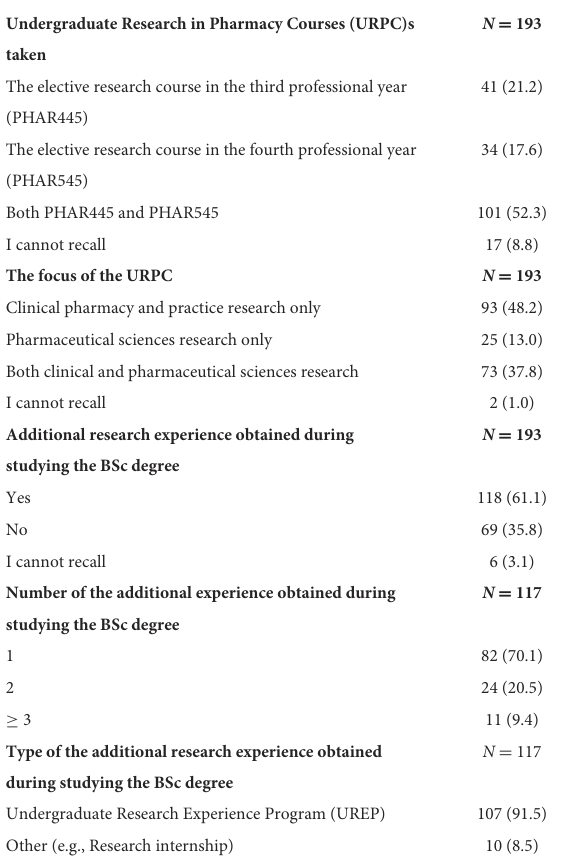
TABLE 2 Participants’ research